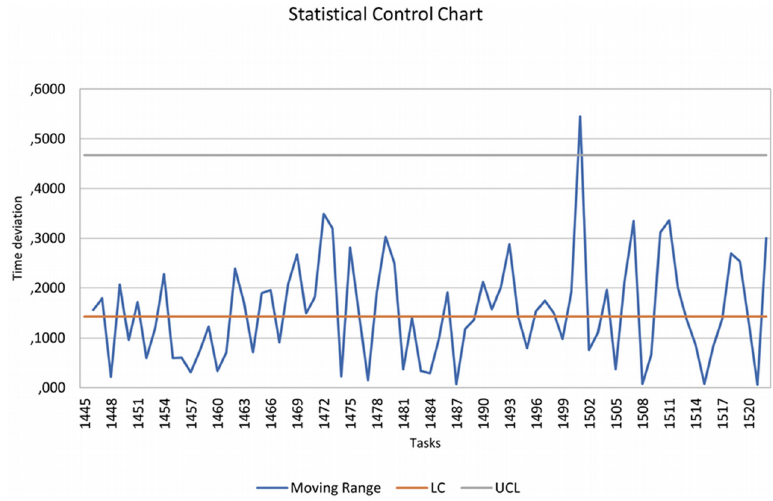
Figure 4. MR-chart for learning